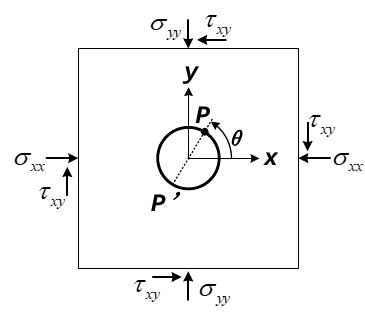
Figure 1. Borehole in a plane-strain condition.